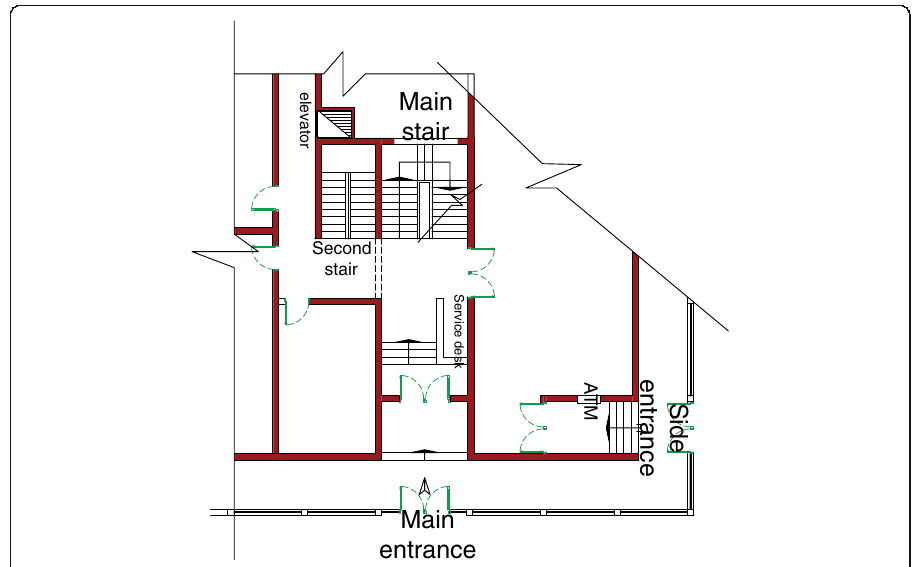
Fig. 19 The floor sketch plan for entrance and stairs in building C. Drawn by the researcher